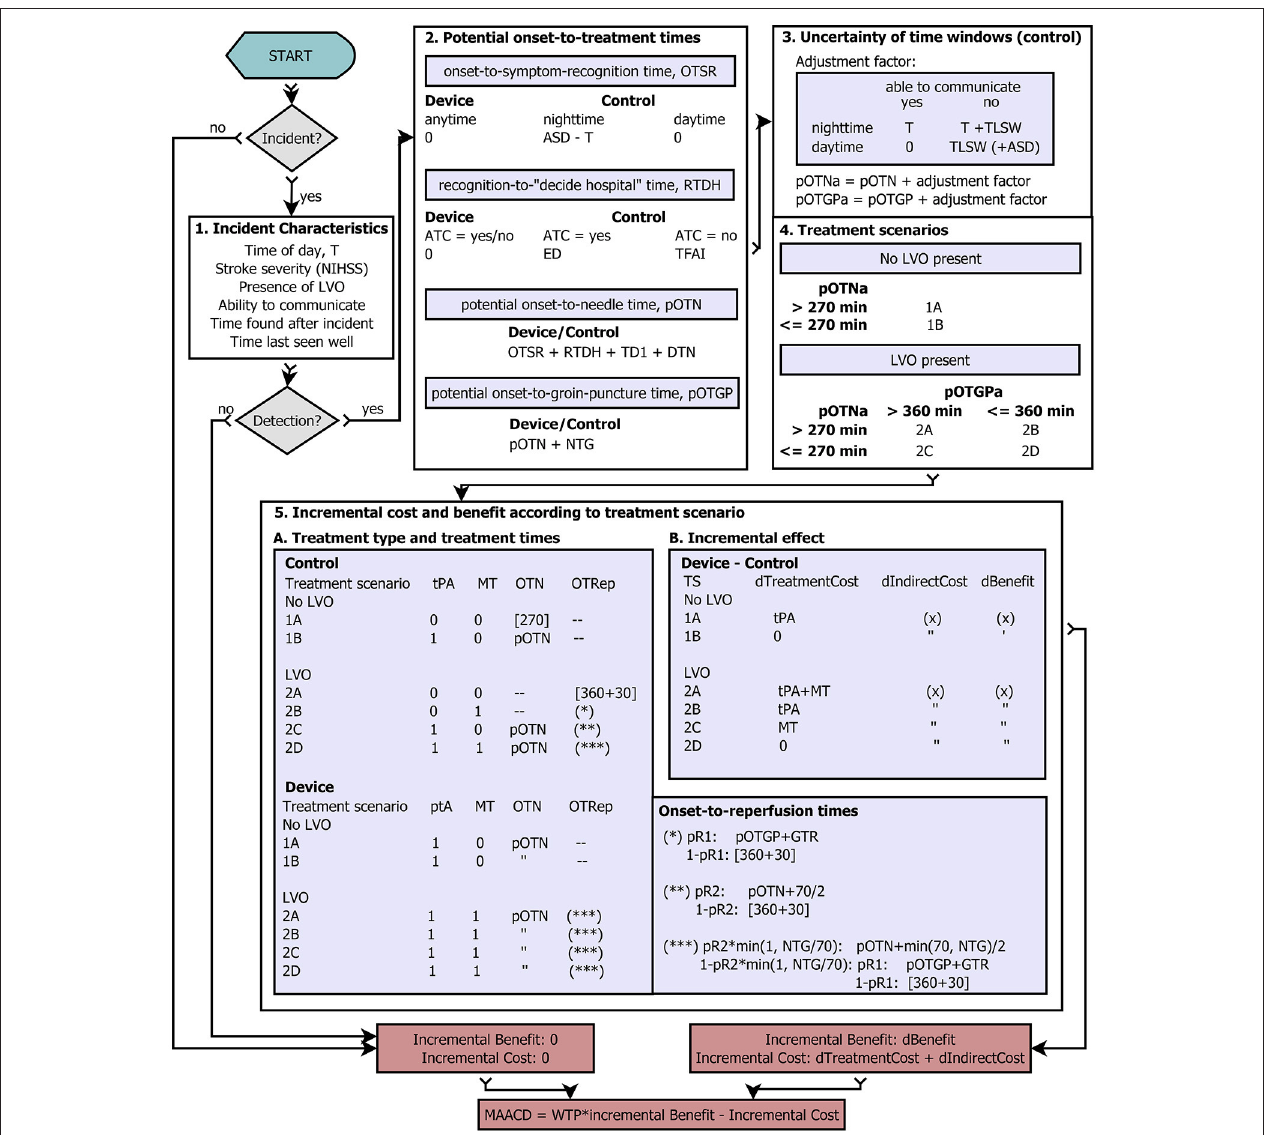
FIGURE 1 | Flow diagram. Graphic representation of the probabilistic conditional model. For a detailed description, see main text. (x) represents multi-parametric functions of age, sex, NIHSS, and reduction in symptom onset-to-needle/symptom onset-to-reperfusion times. If patients do not fulfill the time-based eligibility criteria for thrombolysis or mechanical thrombectomy, or if no reperfusion is achieved, the upper end of the respective treatment time window at which the administration of the respective treatment is associated is with no benefit used for the calculation of the reduction in time-to-treatment (indicated by brackets []). General Abbreviations: T stand for the time of day at which the acute ischaemic stroke incident occurs, NIHSS for National Institutes of Health Stroke Scale, LVO for large vessel occlusion, ASD for average sleep duration (night time), ATC for ability to communicate (i.e., call emergency medical services and/or give information about symptom onset), tPA for intravenous thrombolysis with tissue-type plasminogen activator, MT for mechanical thrombectomy, TS for treatment scenario, pR1 for the probability of reperfusion of large vessel occlusion during mechanical thrombectomy, pR2 for the Probability of reperfusion of large vessel occlusion 70min after intravenous thrombolysis, WTP for willingness-to-pay threshold, and MAACD for the maximally allowable annual cost of the device. Time interval abbreviations: OTSR stands for symptom onset-to-recognition time, RTDH for symptom recognition-to-(decision to go to hospital)-time, ED for prehospital delay between recognition of symptoms and the decision to go to a thrombolysis-ready hospital attributable to poor education about stroke symptoms, TFAI for the average time a patient is found after an incident, pOTN for potential symptom onset-to-needle time, pOTGP for potential symptom onset-to-groin puncture time, pOTNa and pOTGPa for potential symptom onset-to-needle time and potential symptom onset-to-groin puncture time, respectively, after adjustment for the uncertainty of time windows, TD1 for travel time to the nearest thrombolysis-ready hospital, DTN for door-to-needle time, NTG for needle-to-groin puncture time, TLSW for the average time a patient was last seen well before the incident, OTRep for symptom onset-to-reperfusion time.